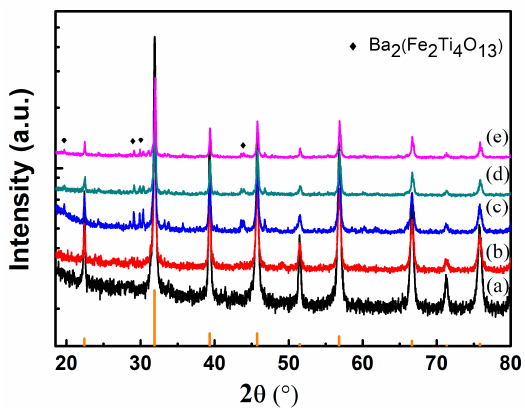
Figure 8. XRD patterns of BST@Fe 2 O 3 ceramics with different coating amounts ( a ) 0 wt%, ( b ) 2.5 wt%, ( c ) 5 wt%, ( d ) 7.5 wt%, and ( e ) 10 wt%.